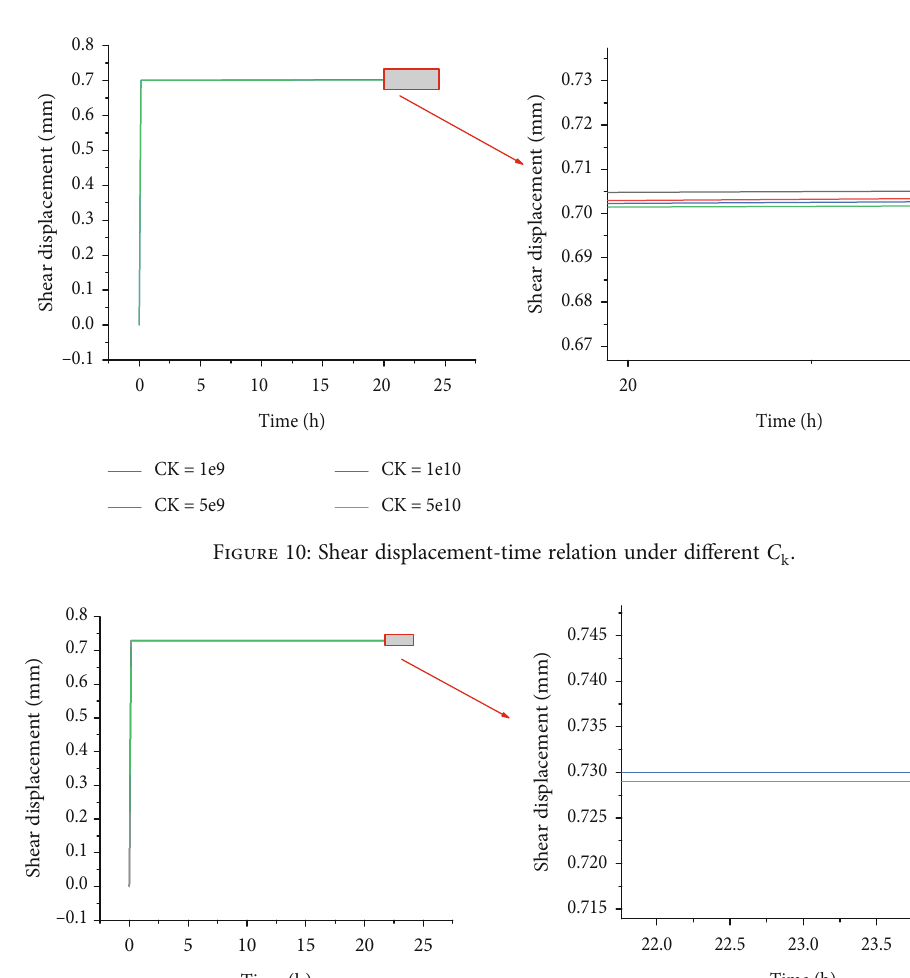
k conditions with bolt.